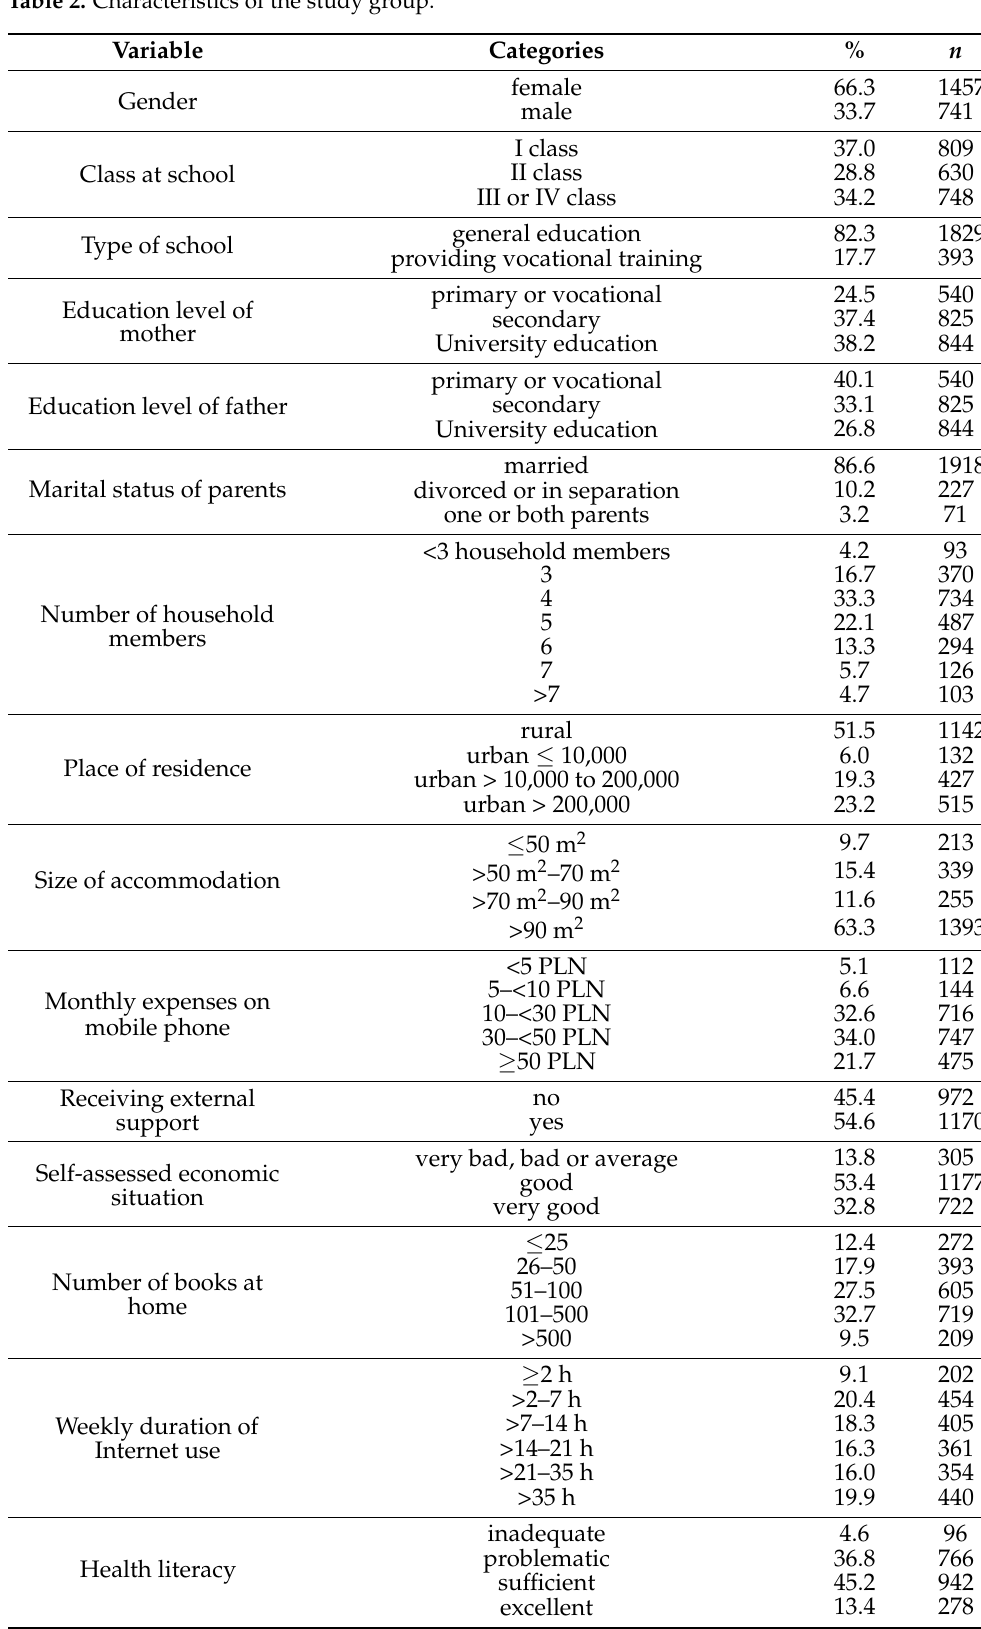
Table 2. Characteristics of the study